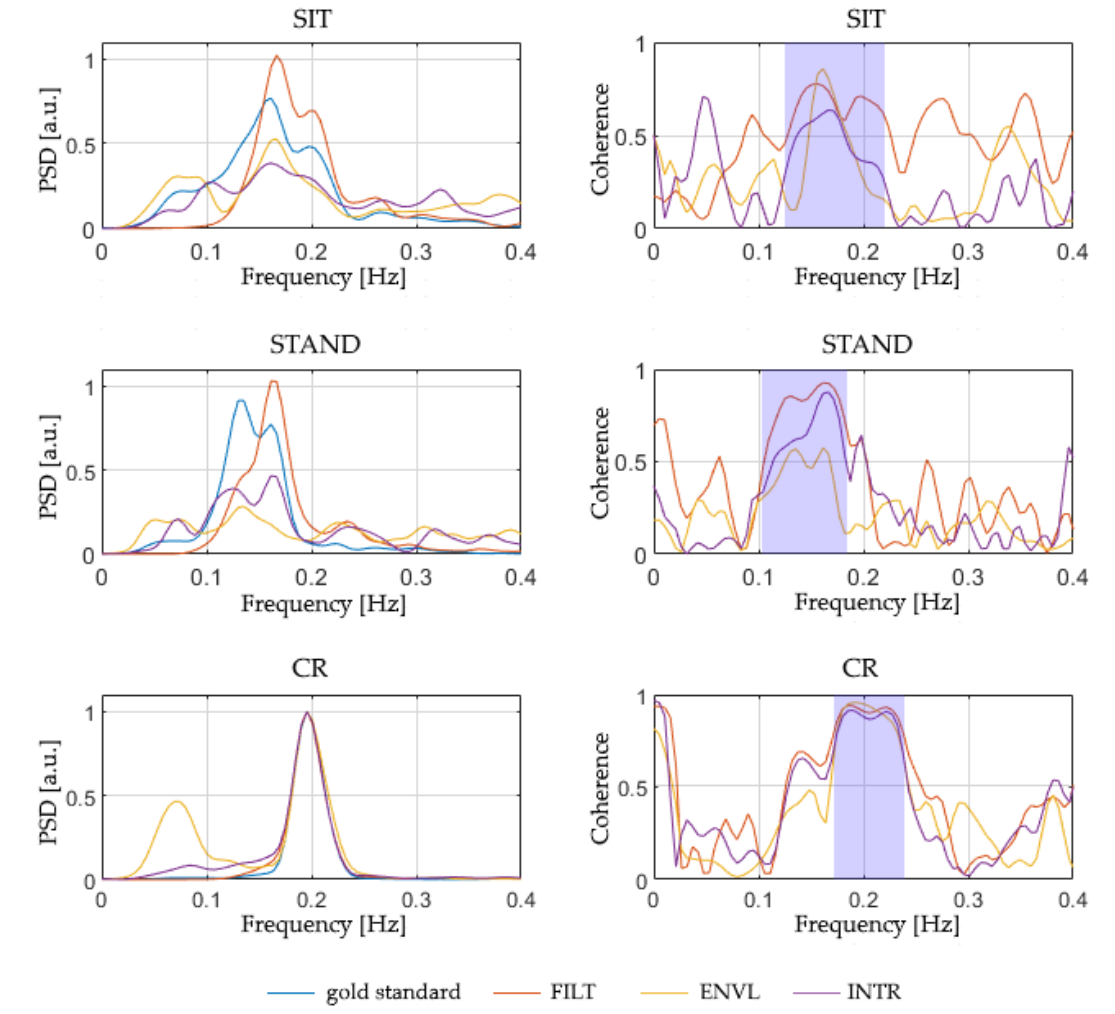
Figure 8. Example of PSD and magnitude-squared coherence computed for a single subject with the examined breathing signal estimation methods from a 64 Hz PPG signal. The shaded area in the coherence charts indicates the relevant frequency band selected for the participant.